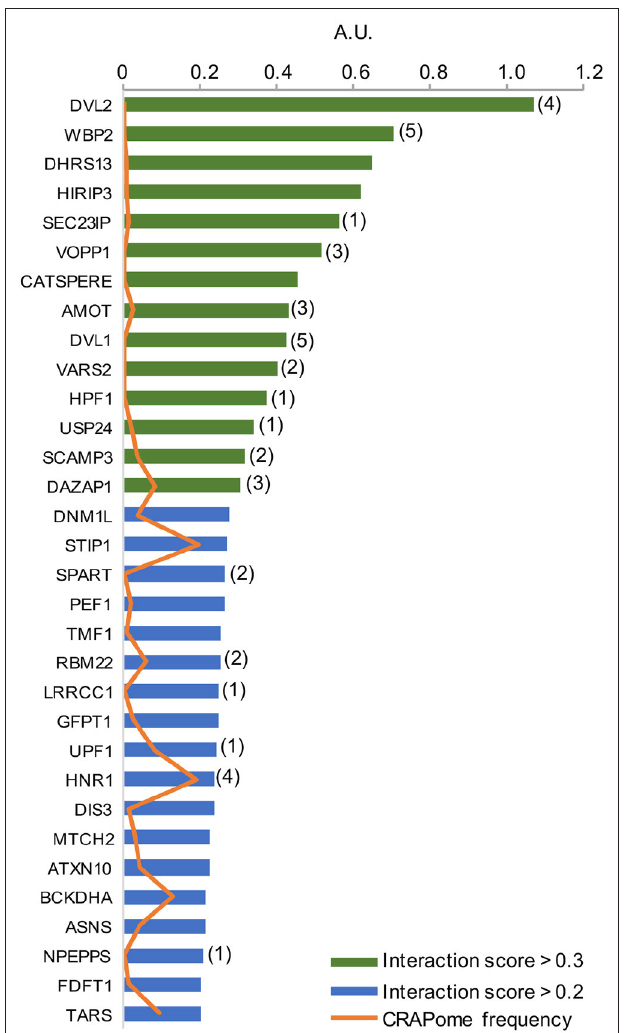
FIGURE 2 | High confidence WWOX protein interactors. Graph showing candidate WWOX interacting partners with interaction score (IS) > 0.2. Bars in green represent the set of 14 proteins with an extremely high likelihood of being direct physical WWOX binding proteins with IS > 0.3. Bars in blue represent good candidate WWOX direct binding proteins with IS < 0.3 and > 0.2. Numbers in parenthesis next to bars represent the number of potential WWOX binding motifs for each respective interacting protein. The orange line graph represents CRAPome frequency for each WWOX binding protein.